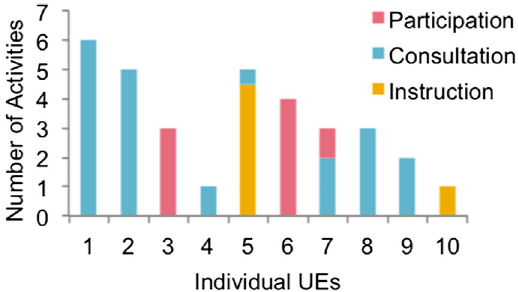
FIG. 6. Modal consistency of UEs. Individual UEs are num- bered on the x axis ( n ¼ 10 ). UEs 1 – 4 were returning volunteers with at least one semester of previous participation. UEs 5 – 10 were new volunteers. Five of the seven UEs that were recorded for at least three activities are not observed to change modalities, either within an activity or from activity